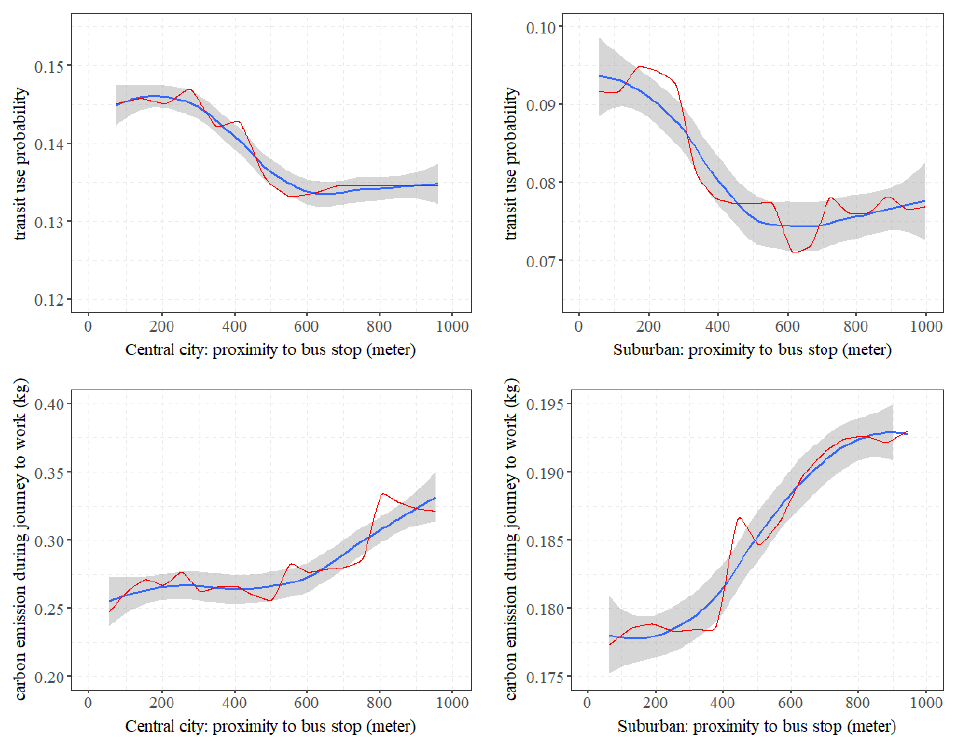
Figure 3. Proximity effects on transit use and commuting-related carbon emission.